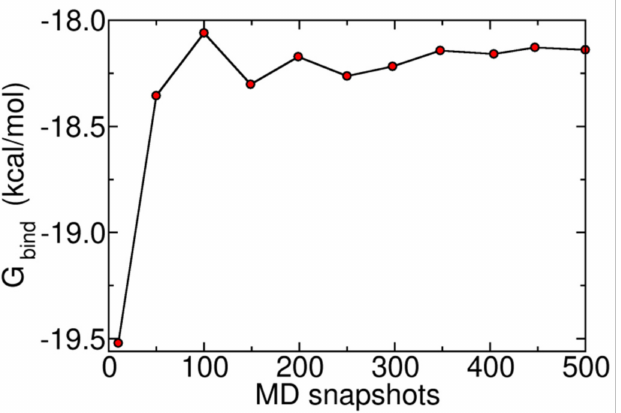
Figure 9. Convergence analysis for the G bind calculation. G bind value versus MD snapshots evaluated for the case of